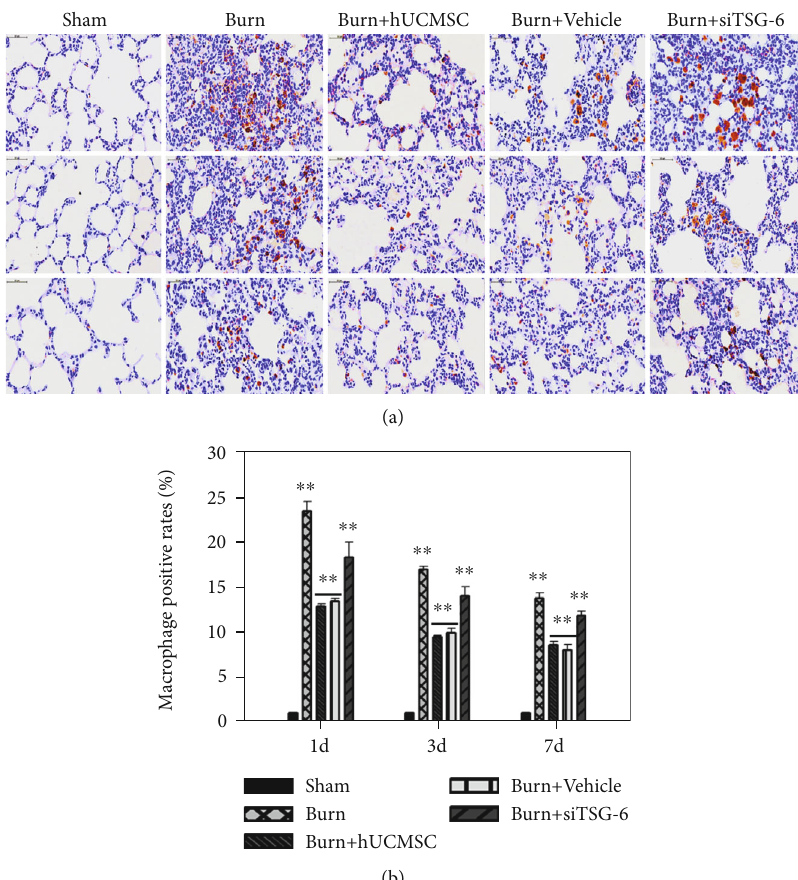
Figure 4: E ff ects of TSG-6 secretion and knockdown on macrophage in fi ltrations of lung tissues induced by severe burn. (a) Representative photographs of CD68 + in lung tissues using immumohistochemical staining are shown (the light microscope, 400x). (b) The quantitative analysis is shown in the corresponding histogram. Values are represented as mean ± SD ( n = 6 ). Asterisk ( ∗ ) and double asterisk ( ∗∗ ) stand for p < 0 : 05 and p < 0 : 01 ,